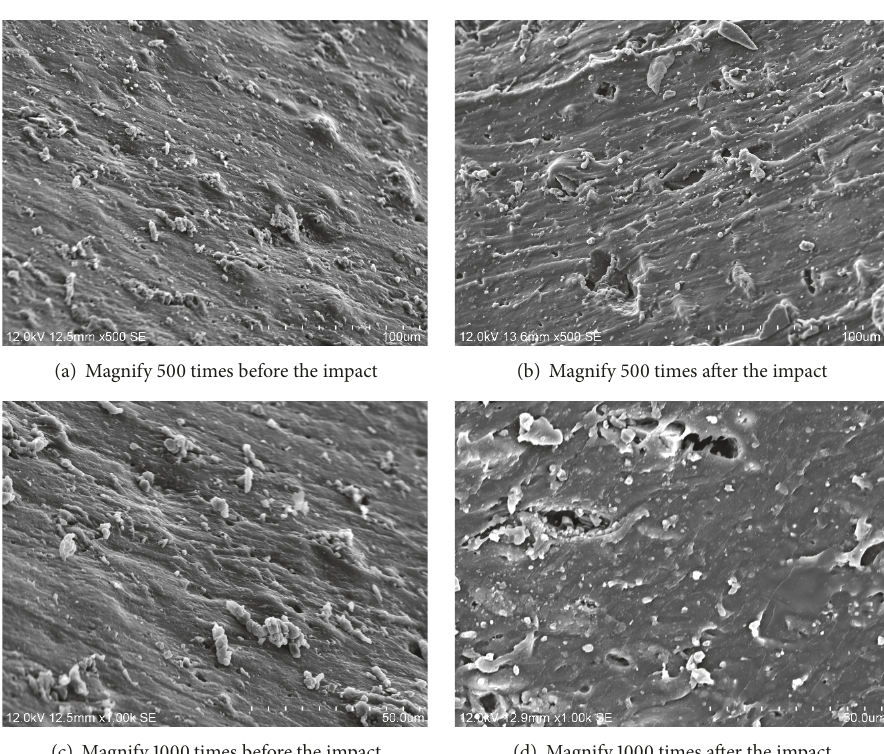
Figure 17: Microstructure of sample before and after